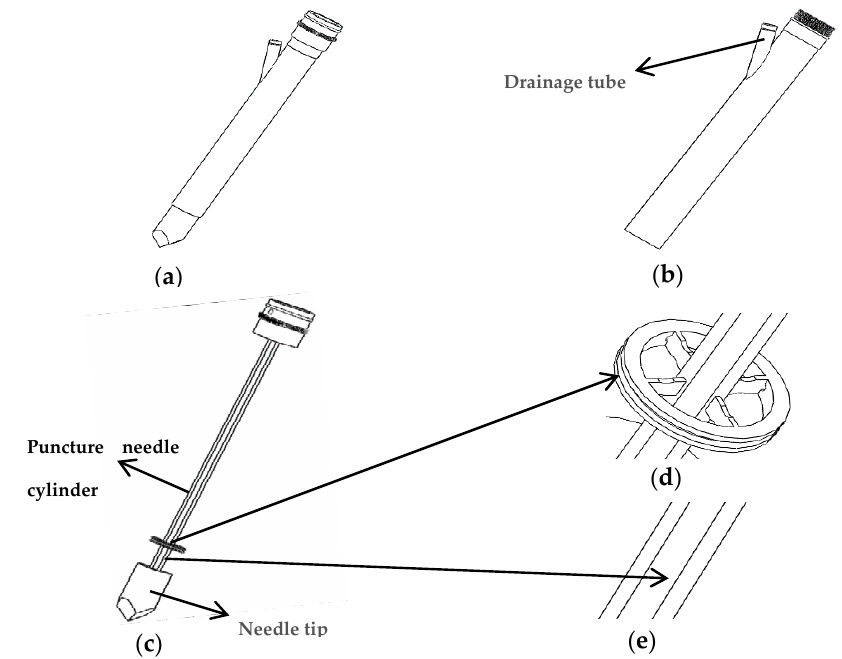
Figure 1. The new type of puncturing needle sensor: ( a ) Overall structure of the puncturing needle; ( b ) External sleeve of the puncture needle; ( c ) Internal structure of the puncture needle; ( d ) Spoke-type structure; ( e ) Groove on the surface of the puncture needle cylinder.